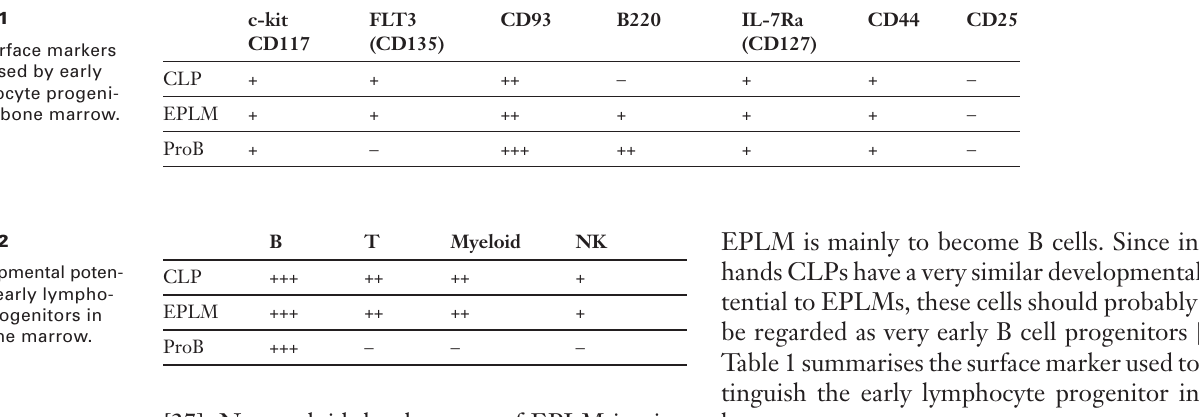
Cell-surface markers expressed by early lymphocyte progeni- tors in bone marrow.